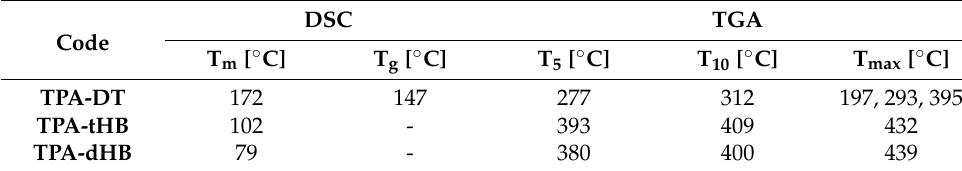
Table 1. Thermal properties of the obtained